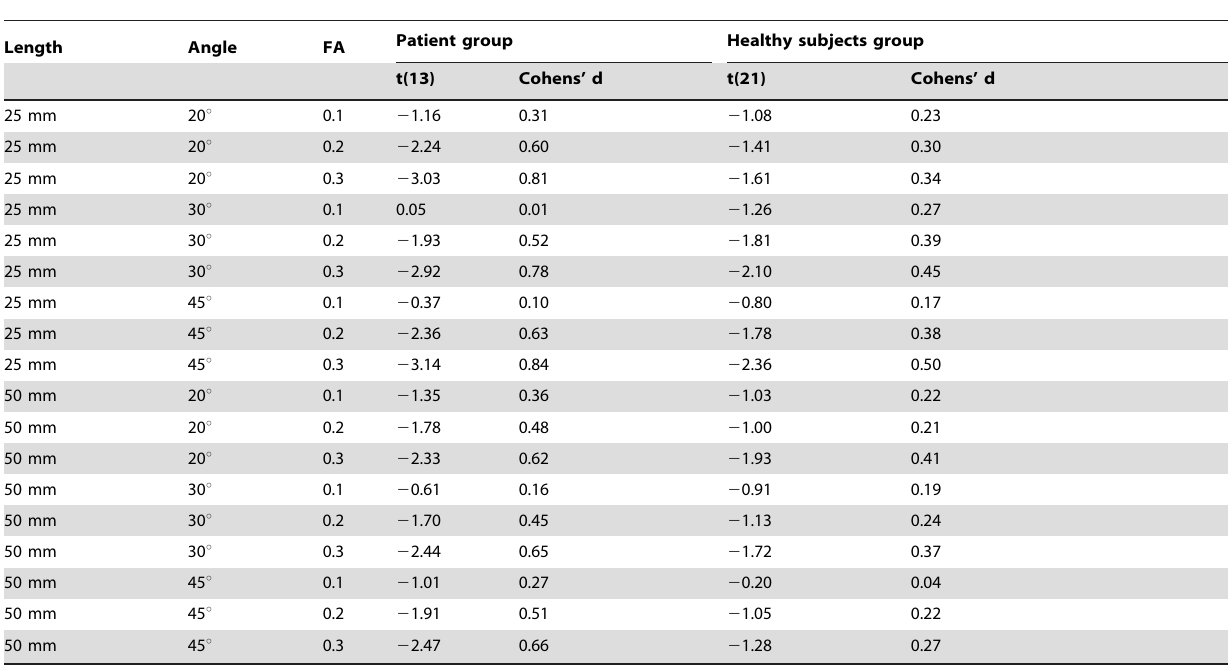
Table 1. t-values and Cohens’d of parameter threshold combinations for patients and healthy subjects.